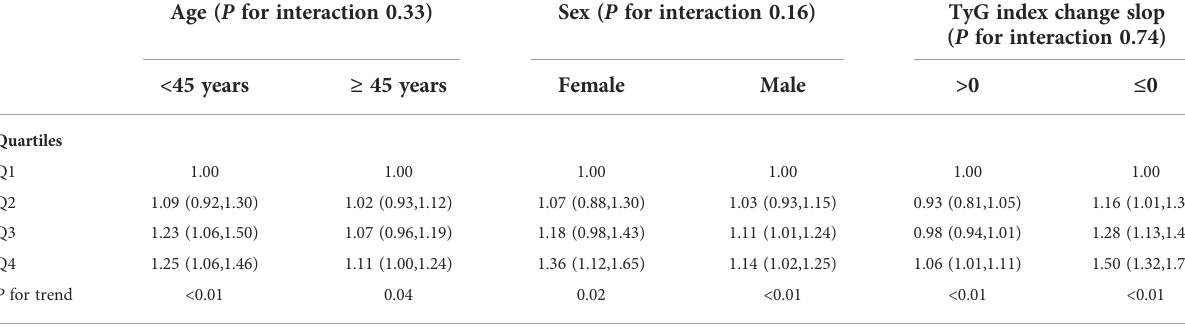
( P for interaction 0.74)